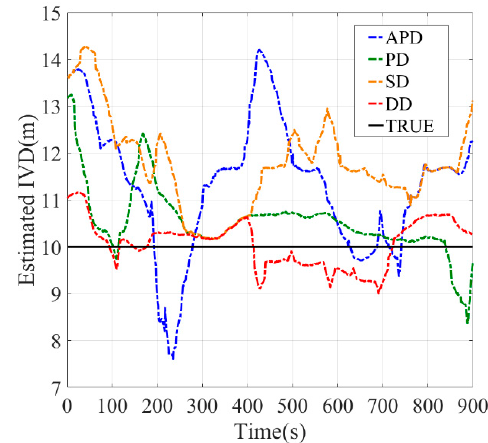
Figure 11. Baseline = 10 m.